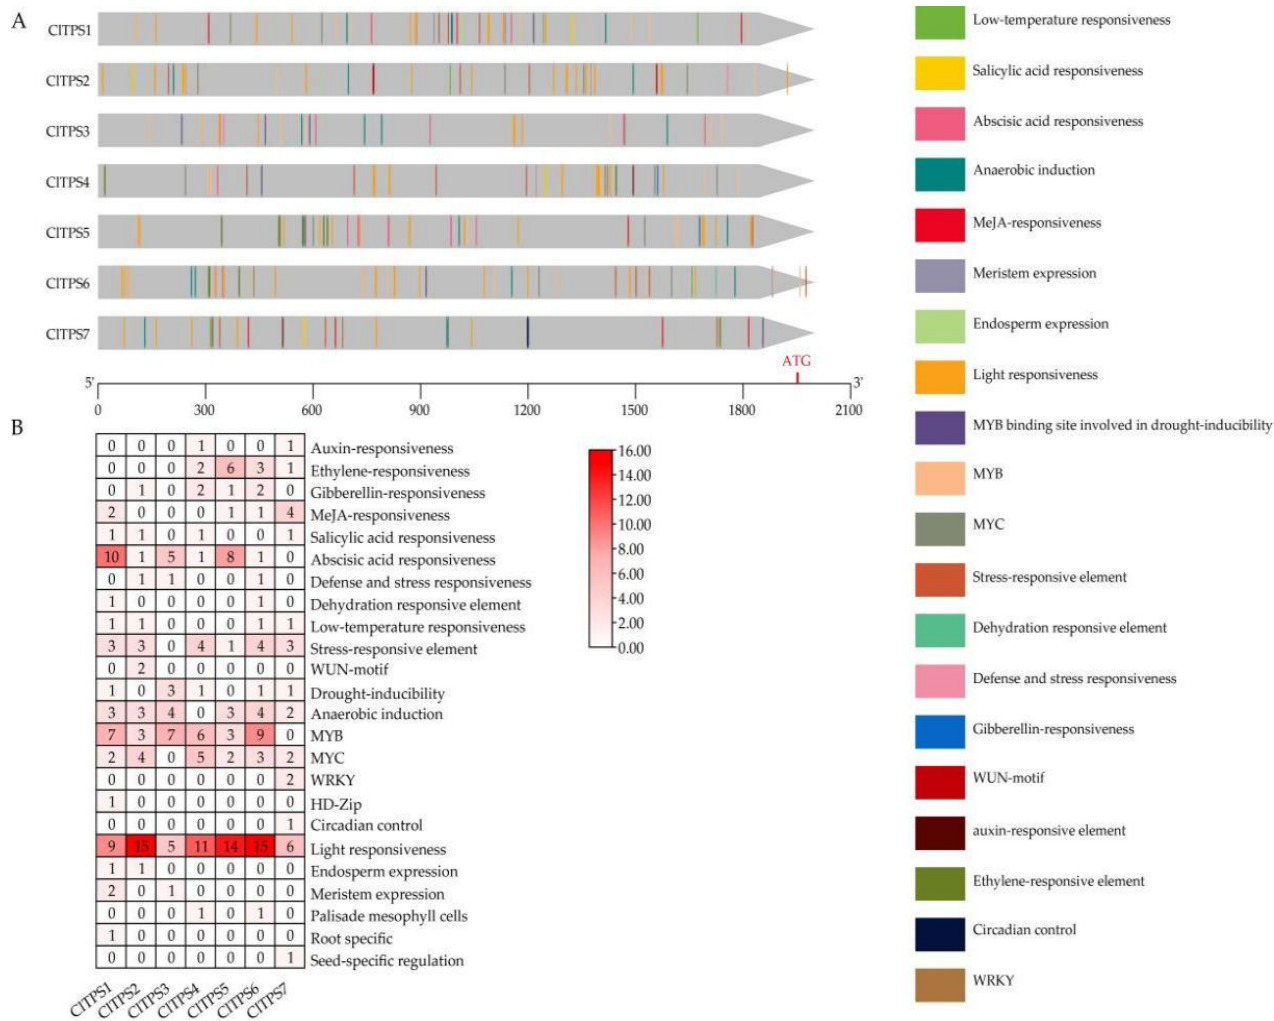
Figure 3 . Phylogenetic analysis, gene structure, and conserved motifs of ClTPSs. ( A ) Phylogenetic analysis of seven ClTPSs. ( B ) Exon/intron organization of ClTPSs. ( C ) Conserved motifs of ClTPSs.